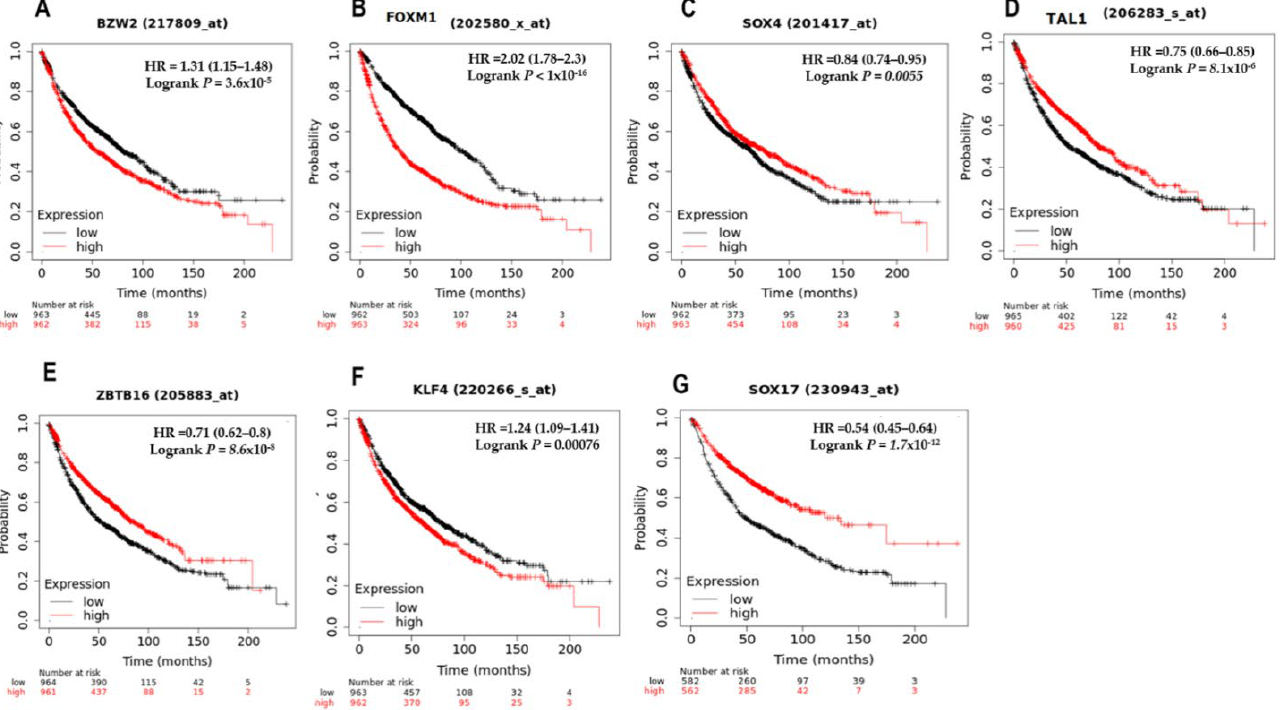
Figure 9. KM plots assessing the correlation between the expression of the top deregulated TFs (mRNA) and survival of lung cancer patients. ( A ) BZW2, ( B ) FOXM1, ( C ) SOX4, ( D ) TAL1, ( E ) ZBTB16, ( F ) KLF4, and ( G ) SOX17.